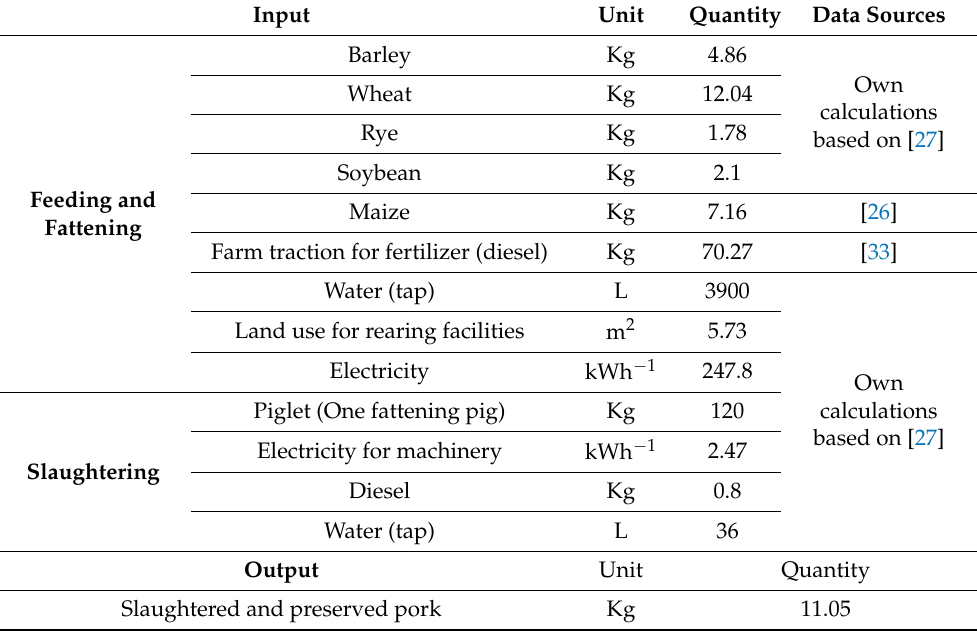
Table 2. Inputs per kg of edible pork protein